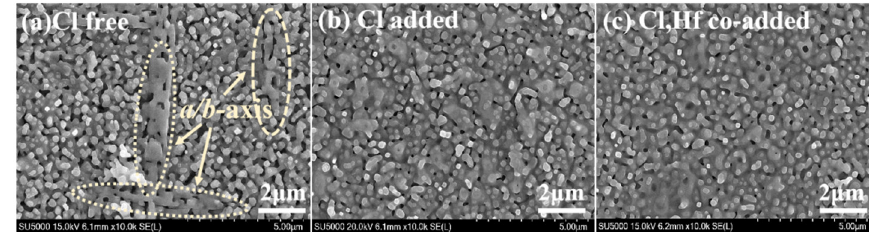
Figure 3. SEM images of Cl-free, Cl-added and (Cl, Hf) co-added YBCO films.